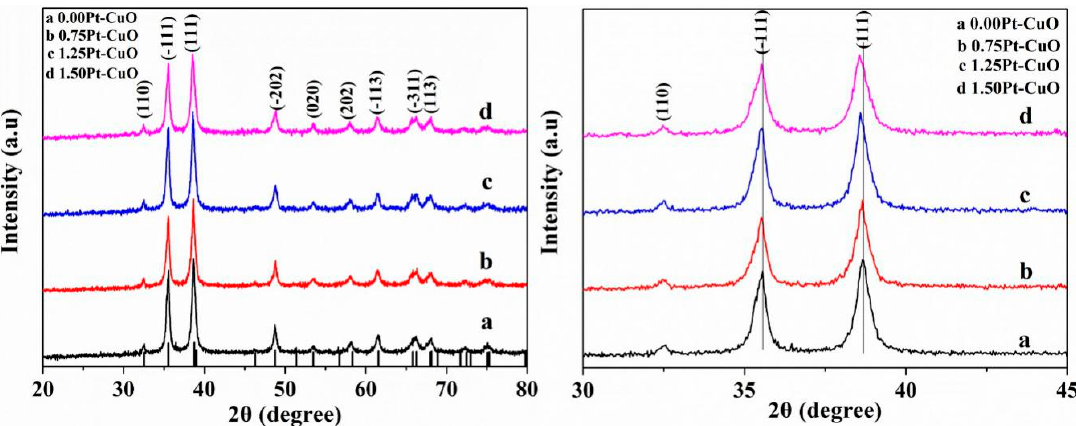
Figure 2. X-ray diffraction (XRD) pattern of the Pt-doped CuO specimens: ( a ) 0.00Pt-CuO, ( b ) 0.75Pt-CuO, ( c ) 1.25Pt-CuO, and ( d ) 1.50Pt-CuO.